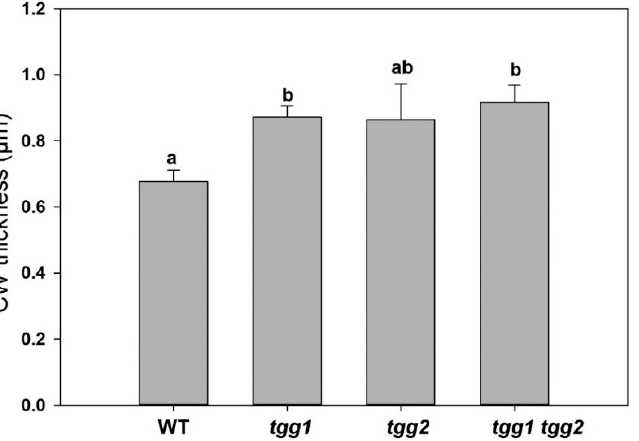
Figure 9. Cell wall (CW) thickness of guard cells as measured from transmission electron micro- graphs of rosette leaves of WT, tgg1 , tgg2 single and tgg1 tgg2 double mutants of Arabidopsis . Error bars represent the means ± SE (WT: n = 17), ( tgg1: n = 17), ( tgg2: n = 8), and tgg1 tgg2 ( n = 20). Differ- ent letters (a and b) above the bars indicate significant differences in guard cell CW thickness be- tween WT, tgg1 , tgg2 and tgg1 tgg2 as determined by a Kruskal-Wallis test followed by a Dunn’s method for pairwise comparisons ( p < 0.05).